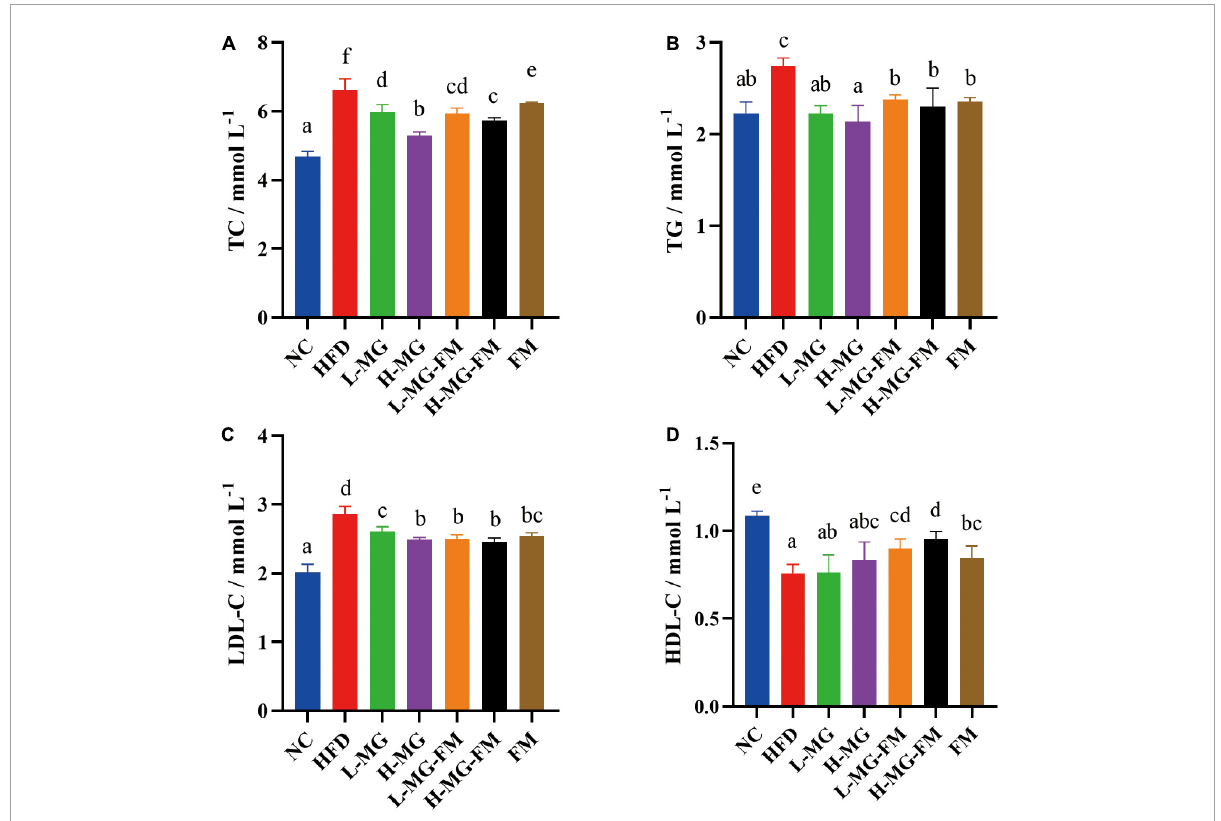
FIGURE2 Serum lipid profiles in mice. The concentrations of (A) total cholesterol (TC), (B) triglyceride (TG), (C) low-density lipoprotein cholesterol (LDL–C), and (D) high-density lipoprotein cholesterol (HDL–C) were measured in serum. Different letters indicate significant differences ( p < 0.05, n = 6).